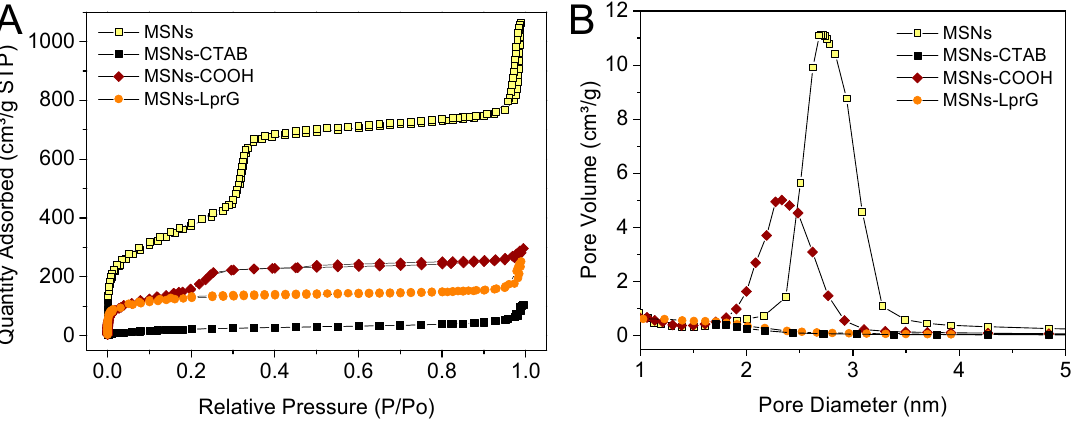
Table 4. Textural parameters of the MSN materials obtained by N 2 adsorption measurements.